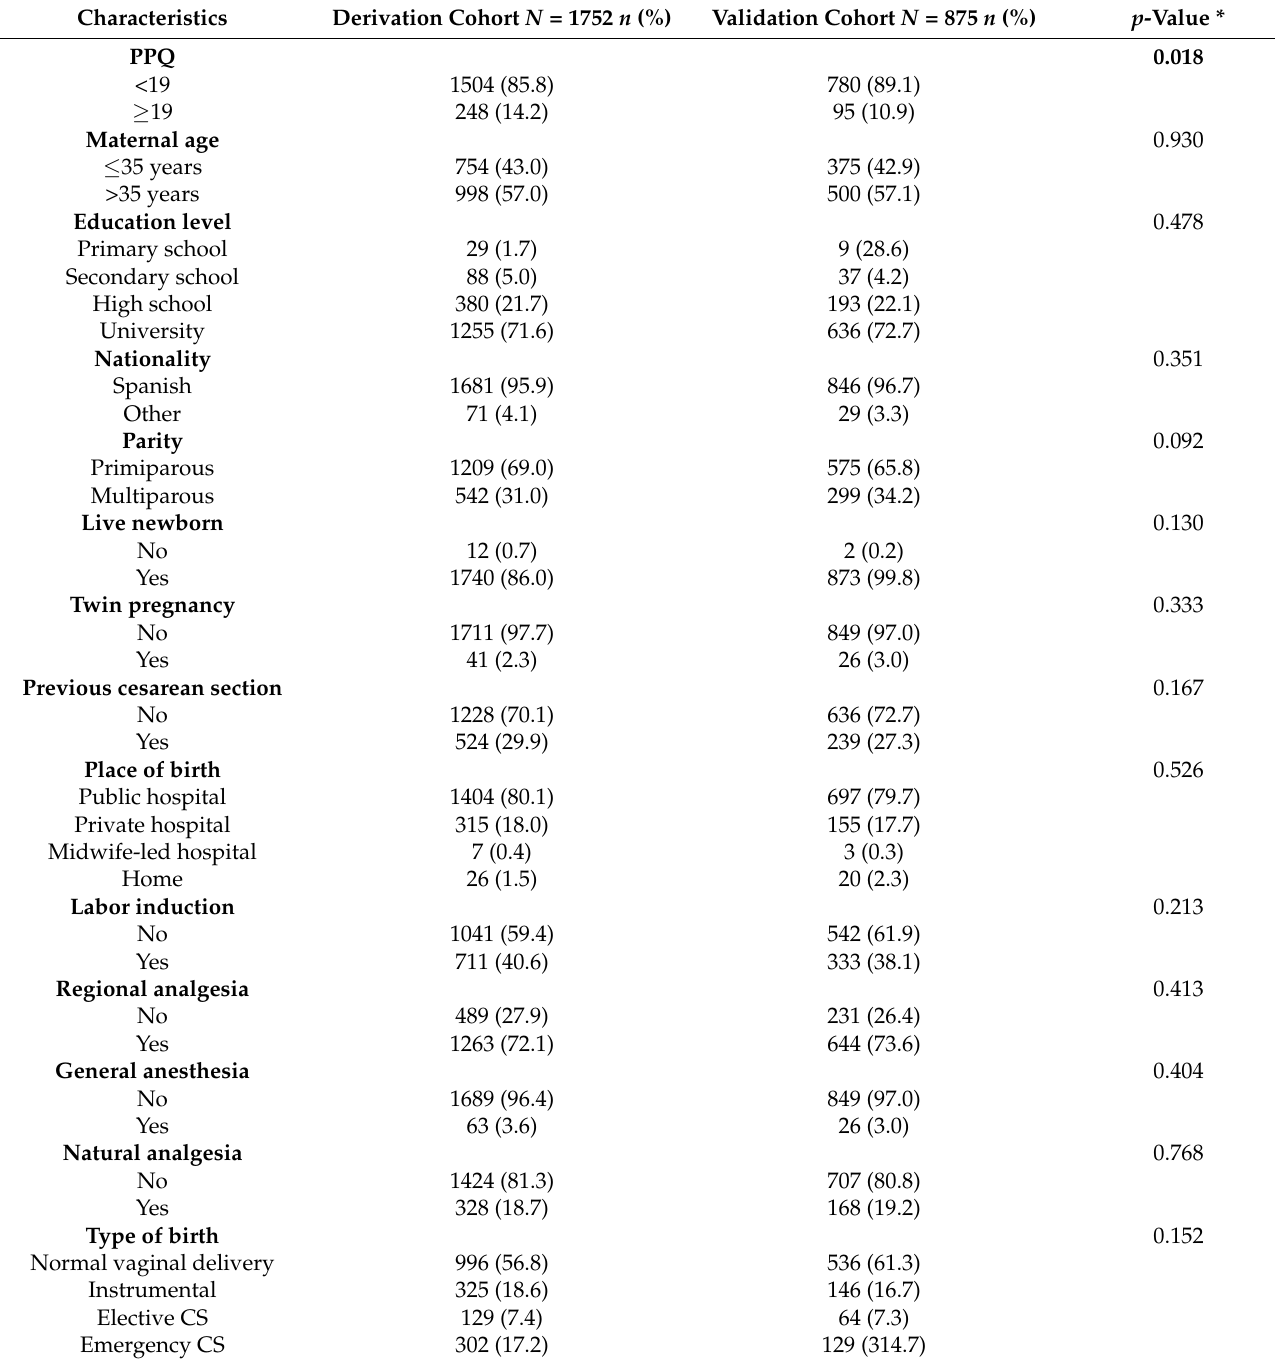
Table 3. Comparison of characteristics between the derivation and validation